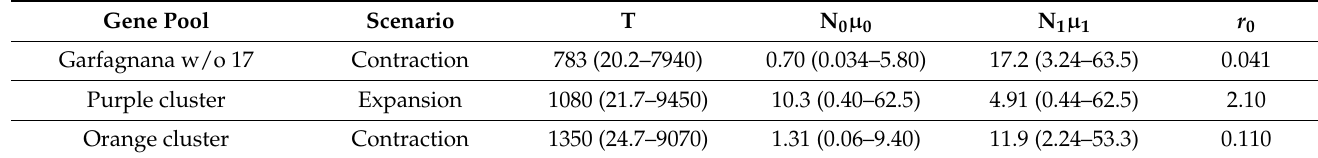
Table 4. Parameter estimation for the Approximate Bayesian Computation (ABC) modelling with free population size variation. All parameter values are provided with their credible interval at